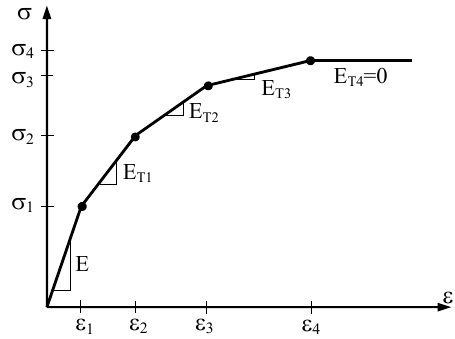
Fig. 6. Uniaxial compressive stress-strain behavior for multilinear kinematic hardening model.